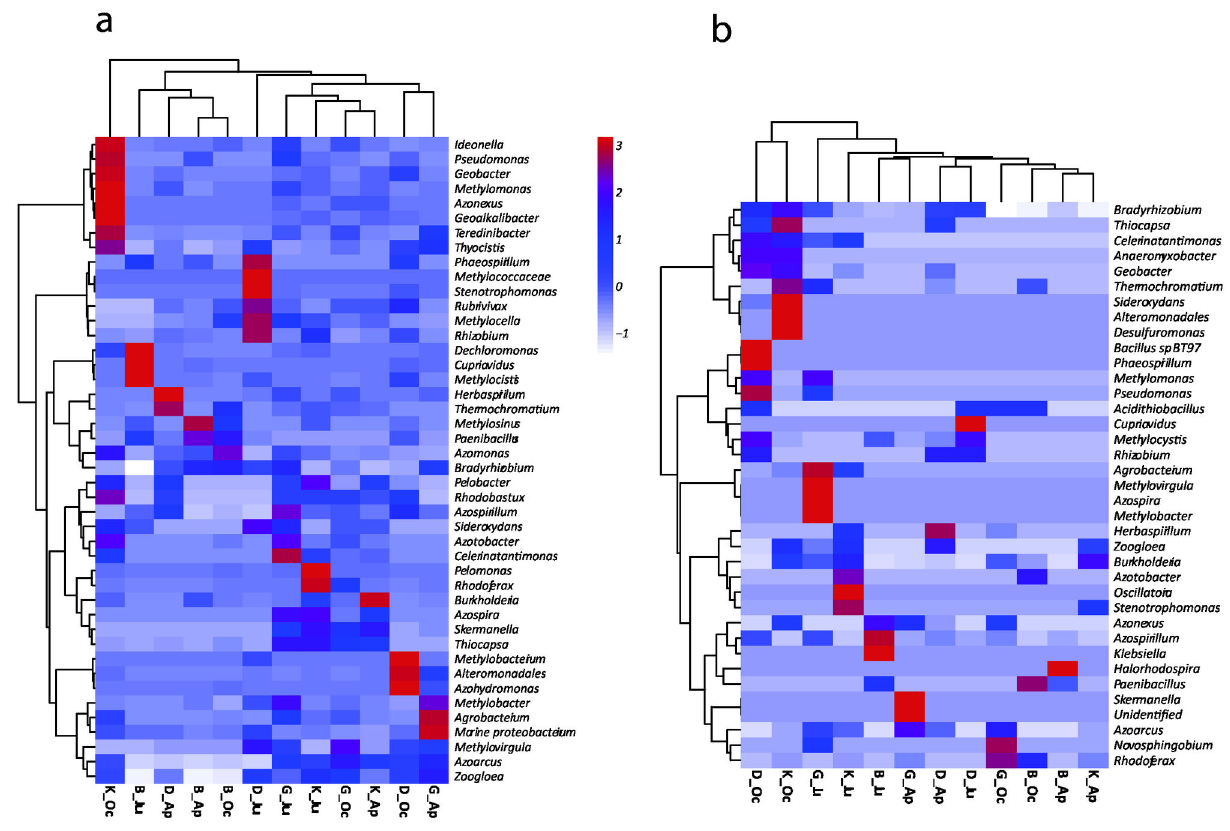
Figure 5. Double dendrogram and heatmap, based on the Ward minimum variance clustering method for abundant genera investigated using nif H gene pyrosequencing. The heatmap indicates the relative abundance of the (a) most abundant and (b) most rare genera within each sample. B, Buinen; D, Droevendaal; K, Kollumerwaard and G, Grebbedijk; Ap, April; Ju, June;